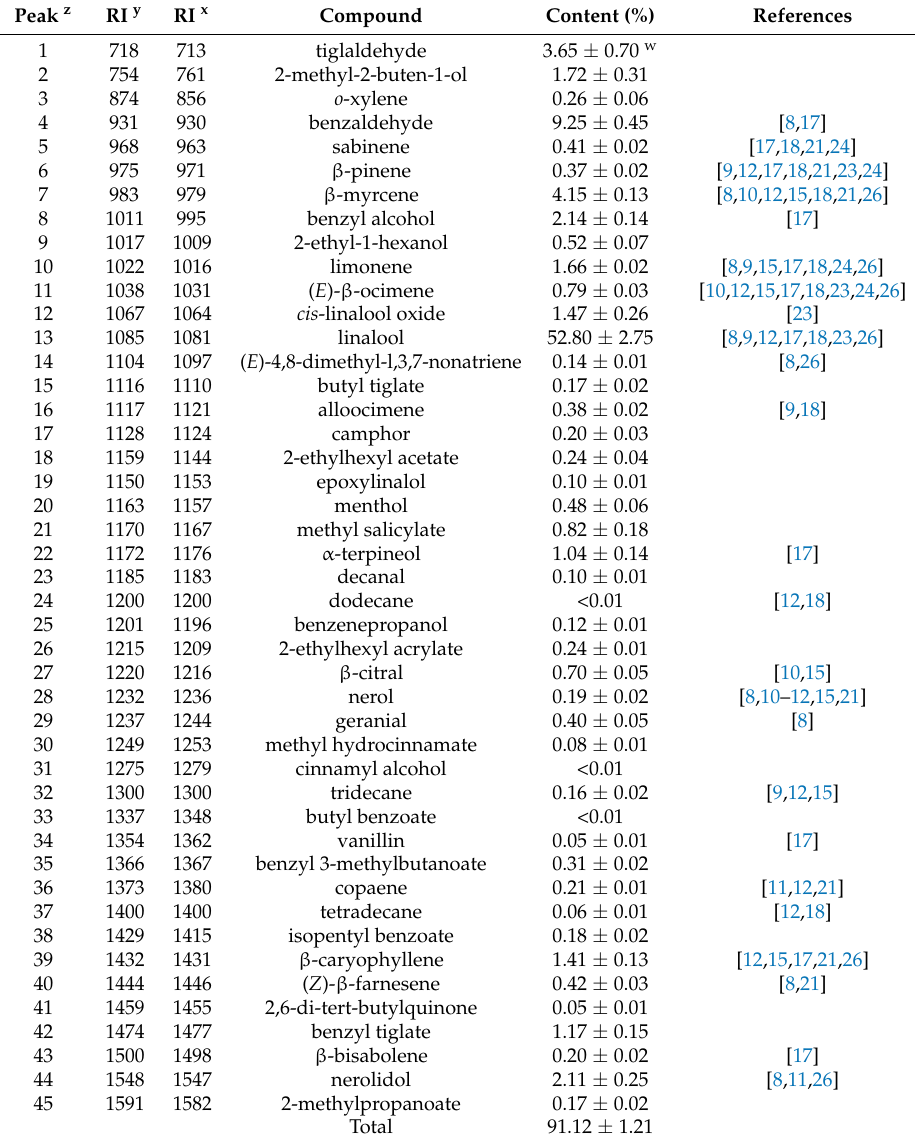
Table 1. Percentages of volatile compounds in Onc. Rosy